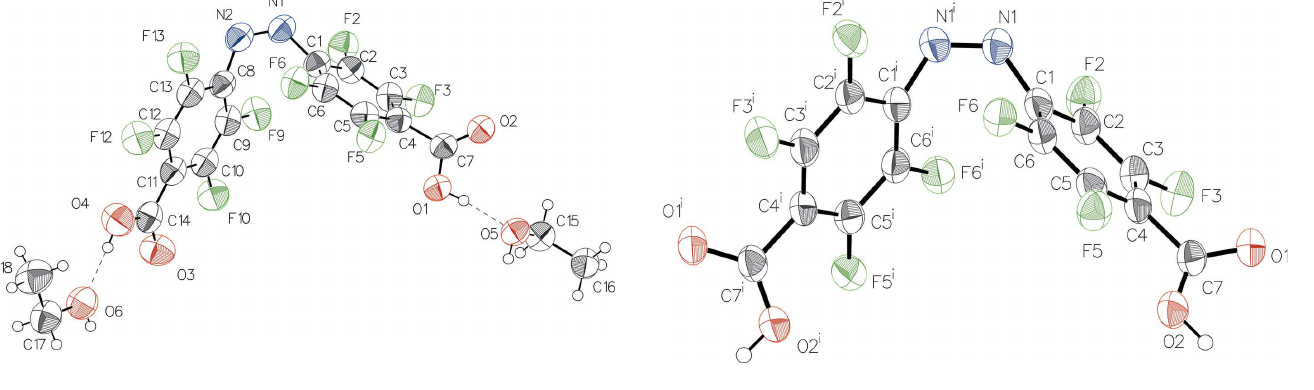
Figure 1 The molecular structure of (I) showing the atom labelling and displacement ellipsoids drawn at the 50% probability level. H atoms are drawn as spheres of arbitrary radius, and hydrogen bonds are shown as dashed lines.